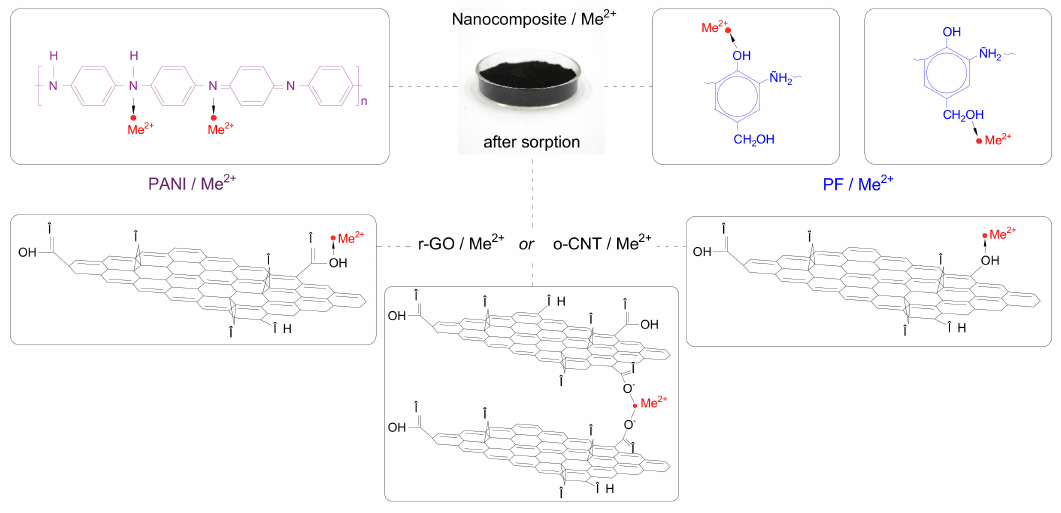
Figure 16. The proposed mechanism for the adsorption of contaminants on the